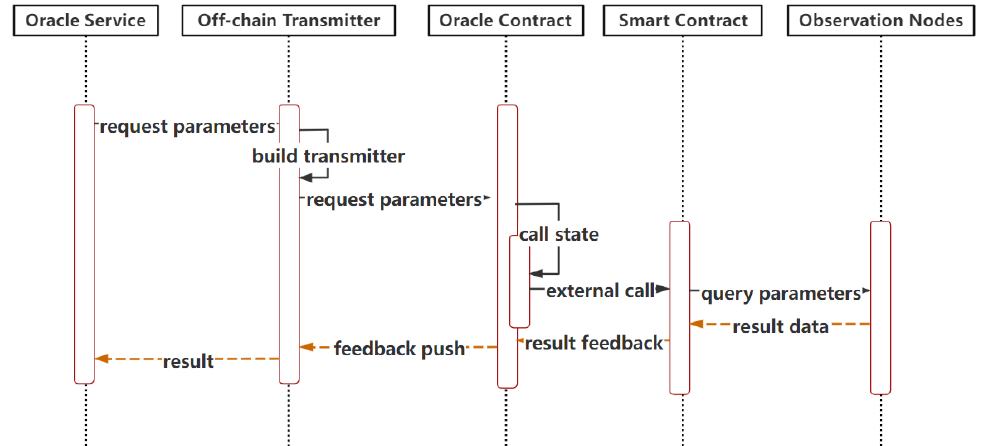
Figure 5. Pull-based outbound